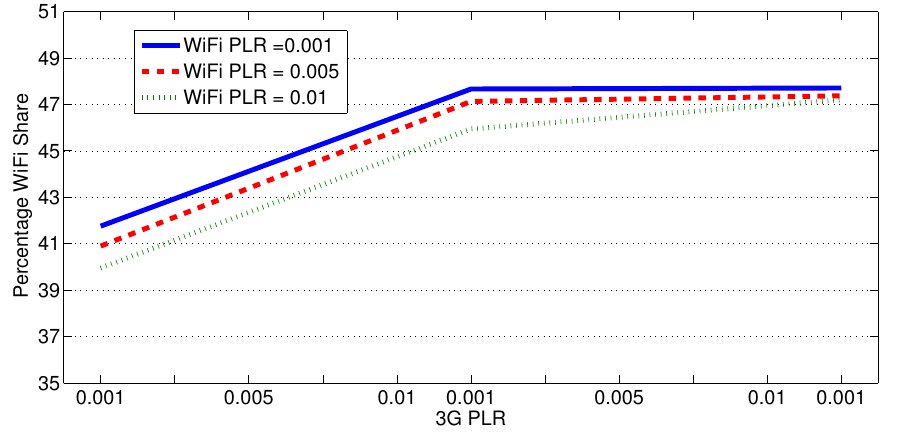
Figure 9. Traffic distribution for subflows with different